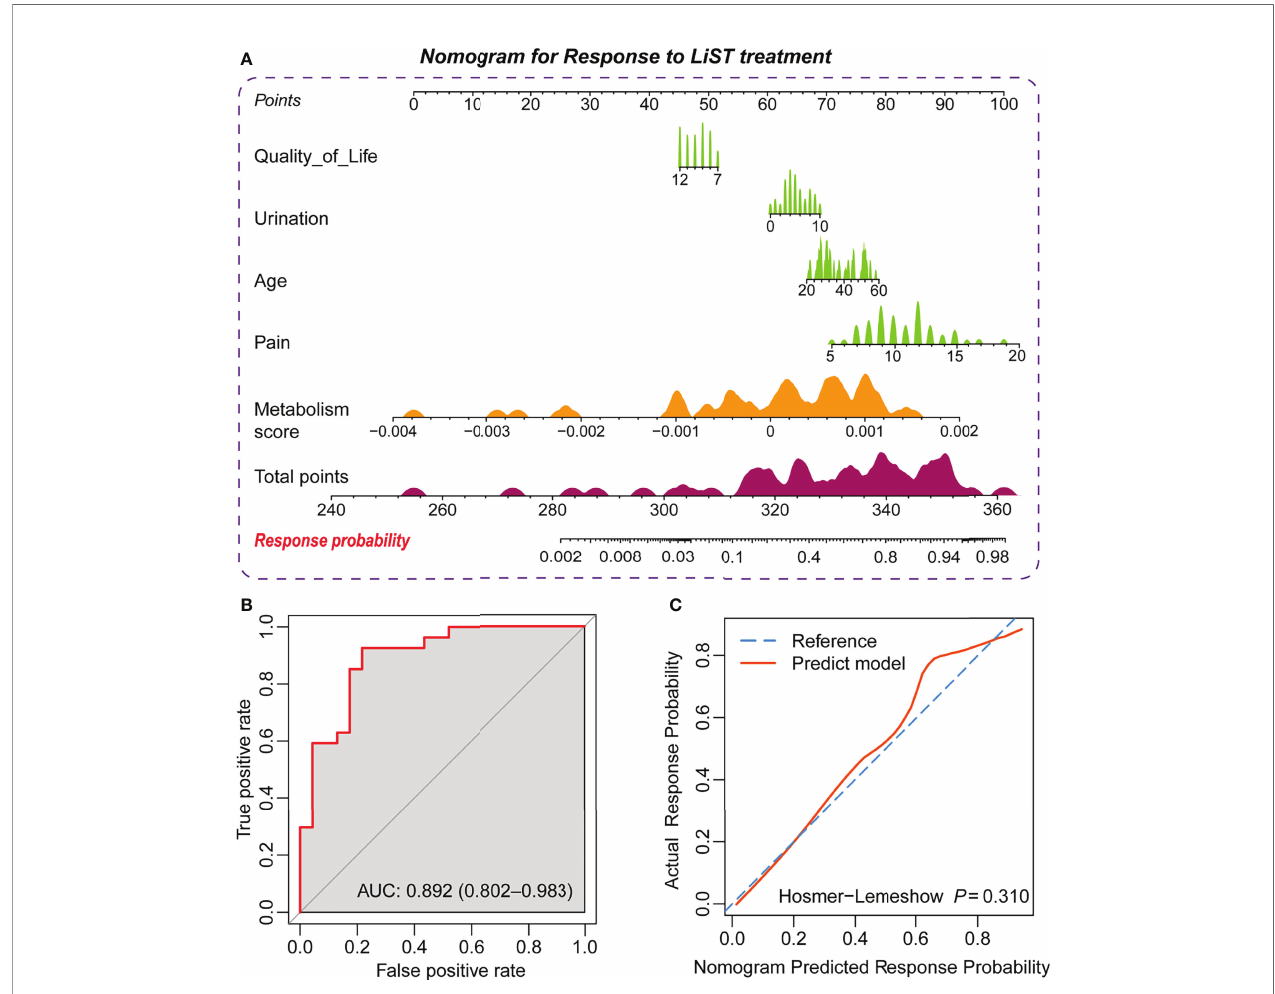
FIGURE 2 | Establishment of the prediction nomogram for the LiST treatment response. (A) Nomogram showing weight of metabolism score, age, score of quality of life, urination, and pain from NIH-CPSI in training cohort; (B) ROC curve showing the prediction value of nomogram; (C) Calibration curve showing the comparison between actual response probability and nomogram predicted response probability.